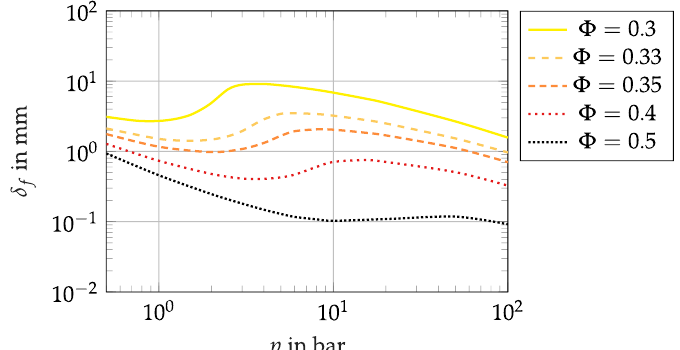
Figure 8. Pressure dependence of the laminar flame thickness obtained from one-dimensional freely propagating flame